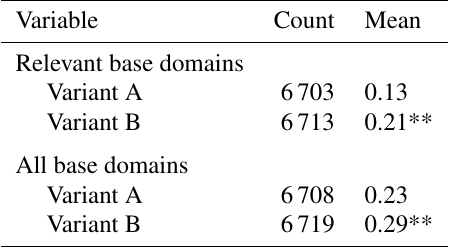
Table 2. Average decrease in number of domains with fewer than 30 practiced items. The decrease is higher for the new governing method, indicating on average fewer domains have close to no items practiced after the experiment.